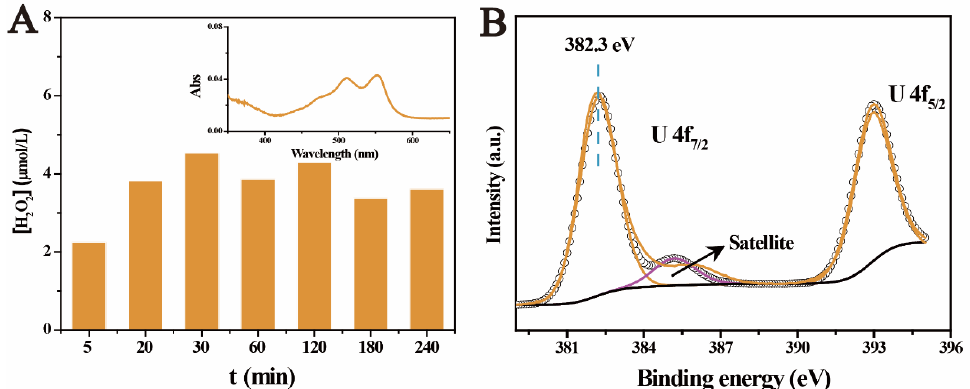
Figure 6. Generation of H 2 O 2 after light irradiation on ferrihydrite ( A ), and the U 4f spectrum of UO 4 •xH 2 O ( B ).